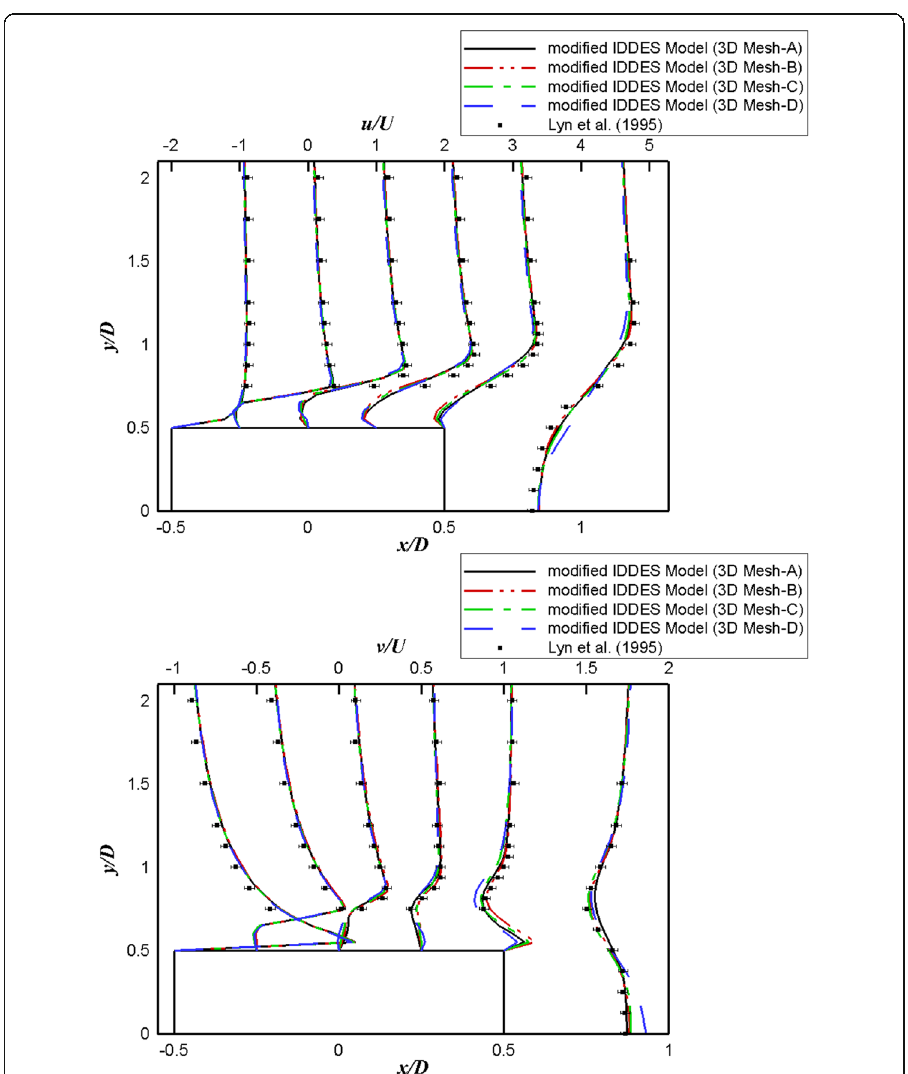
Fig. 12 Mean streamwise (top) and cross-stream (bottom) velocity profiles at different locations near the cylinder predicted by 3D simulations using the modified IDDES